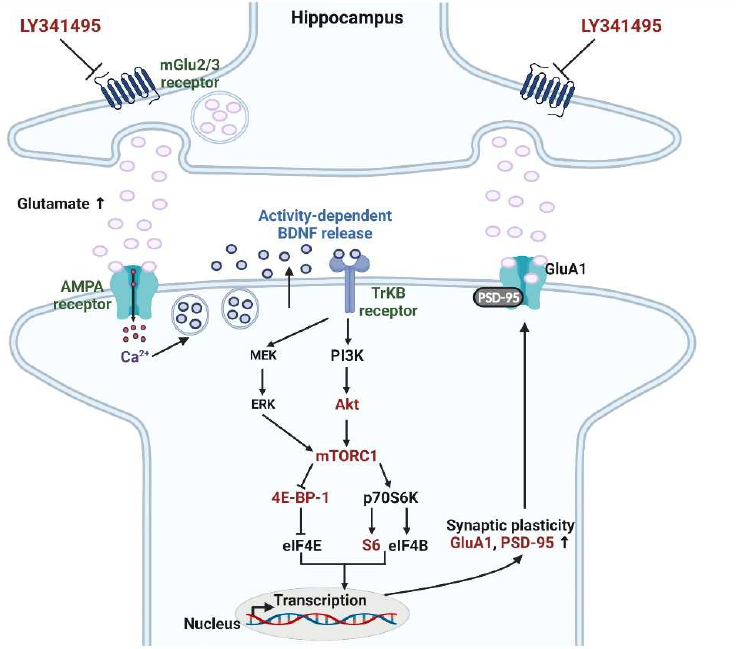
Figure 4. Putative signaling pathway underlying the antidepressant actions of LY341495 in the hippocampus. LY341495 increases extracellular glutamate release, thereby inducing BDNF release. BDNF stimulates the TrkB receptor and downstream signaling pathways PI3K/Akt and MAPK, in turn activating mTORC1 signaling. mTORC1 activates p70S6K and inhibits 4E-BP-1, thereby increasing the translation of transcripts encoding the synaptic proteins PSD-95 and GluA1 (which enhance AMPA receptor transmission). The synaptic plasticity is thus enhanced, and, overall, this process is associated with the antidepressant effects of LY341495. The molecular pathway marked in red are the pathway observed in the current study. Akt, protein kinase B; AMPA, α-amino-3-hydroxy-5-methylisoxazole-4-propionic acid; BDNF, brain-derived neurotrophic factor; Ca 2+ , calcium; eIF4E, eukaryotic translation initiation factor 4E; eIF4B, eukaryotic translation initiation factor 4B; ERK, extracellular signal-regulated kinase; GluA1, AMPA receptor subunit GluA1; MEK, MAP/ERK kinase; mGlu2/3, metabotropic glutamate 2/3; mTORC1, mechanistic target of rapamycin complex 1; p70S6K, p70S6 kinase; PI3K, phosphatidyl inositol-3 kinase; PSD-95, postsynaptic density-95; S6, small ribosomal protein 6; TrKB, tropomyosin-related kinase B; 4E-BP-1, eukaryotic translation initiation factor 4E (eIF4E)-binding protein 1. Original illustration created by MK Seo using BioRender (biorender.com, accessed on 15 May 2022).